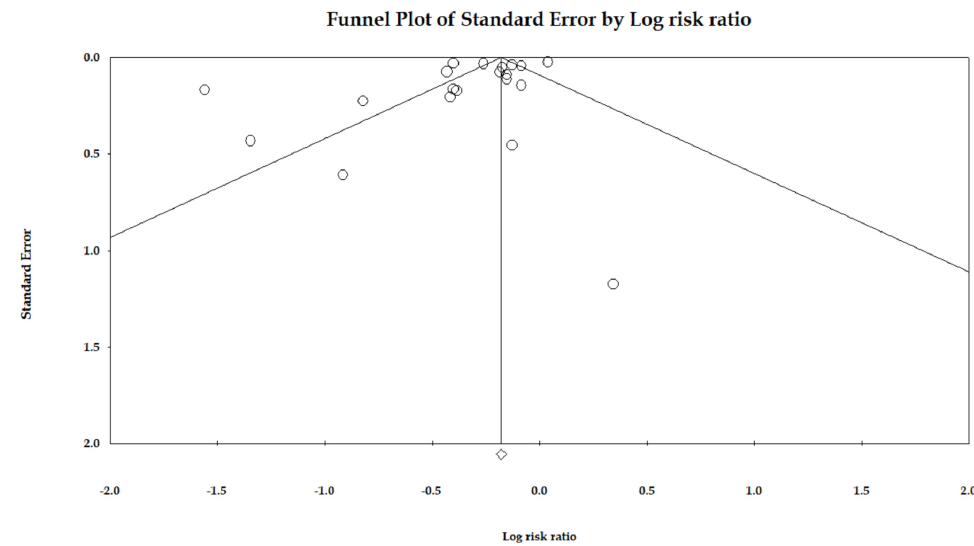
Figure 3. Funnel plot of the association between statin use and risk of gastric cancer.